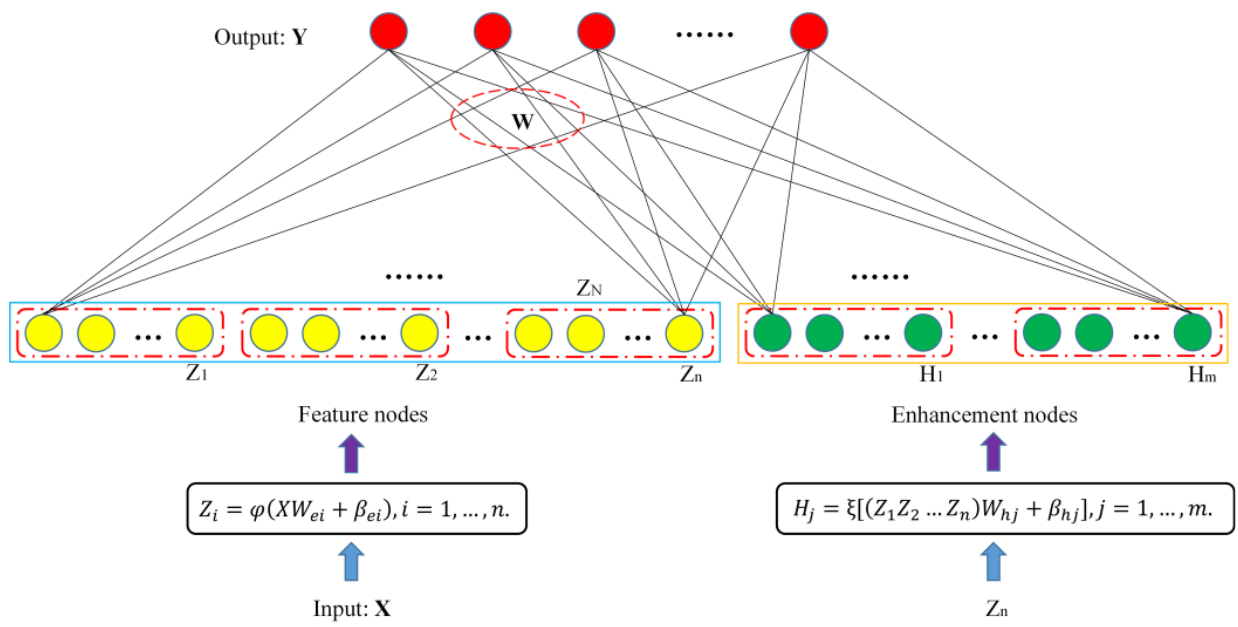
Figure 7. Frame structure of the BLS.